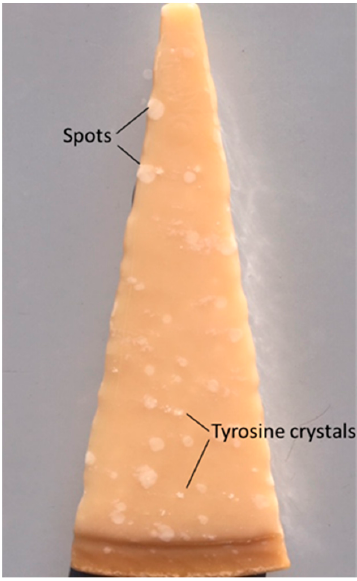
Figure 1. Slice of 40-month ripened Parmigiano Reggiano cheese.